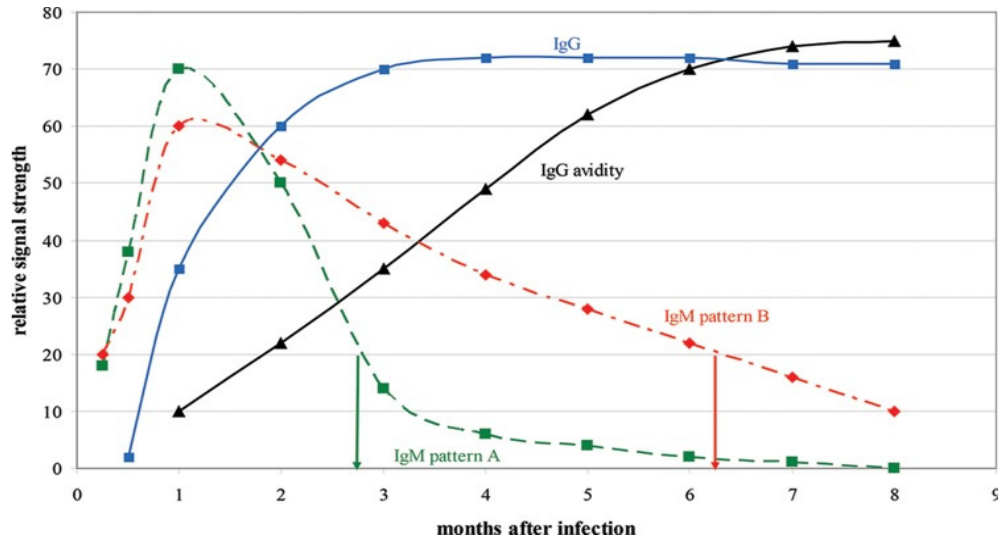
Figure 1. Evolution of CMV IgM, IgG, and IgG avidity levels over time following primary cy- tomegalovirus infection (Prince et al. 2014) [125]. Reprinted with permission from Prince et al. (2014). Copyright 2014, American Society for Microbiology. Note. CMV IgM, IgG, and IgG avidity levels show relative changes over time following primary CMV infection. IgM pattern A represents the typical IgM response pattern, whereas IgM pattern B represents long-term IgM persistence. In a CMV IgG-positive individual, an IgM-positive result of 20 indicates an infection around 3 months ago if the individual exhibits IgM pattern A, but it indicates around 6 months ago if the individual exhibits IgM pattern B. By employing CMV IgG avidity testing, the correct time since infection can be determined: a low-avidity result (expected to be about 30 based on this figure) indicates a primary infection about 3 months ago, whereas a high-avidity result (expected to be about 70) indicates a primary infection more than 6 months